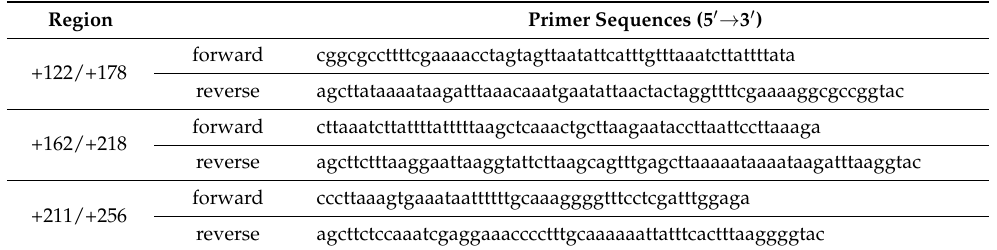
Table A2. Partial TXNIP promoter sequence (+122/+256) of oligonucleotide for annealing.